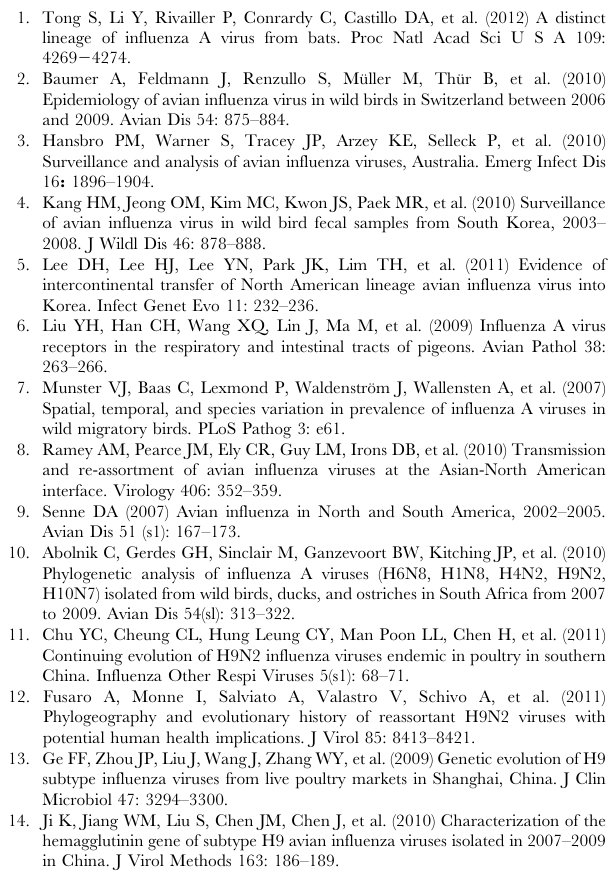
Table S1 The lineage, temporal and spatial distribution of 1178 H9 subtype AIVs reported to GenBank. Table S2 Genetic distances between different levels of H9 lineages. Table S3 Hemagglutination titers of 76 H9 viruses against goose RBCs untreated or treated with a 2,3-specific